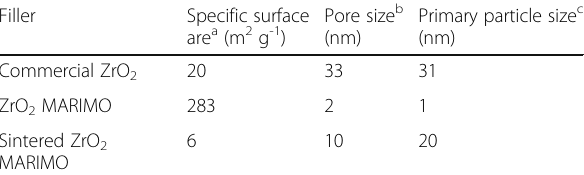
Table 1 Specific surface area and primary particle size of ZrO 2